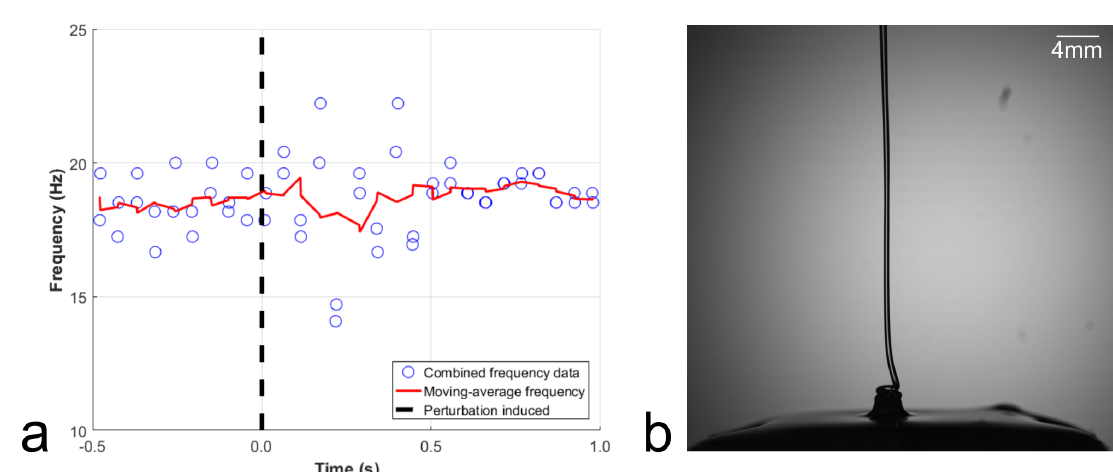
Figure 10. Steady coiling, using honey, around the inertial-gravitational regime induced with a perturbation.The flow rate was 0.85 mL · s − 1 from a fall height of 7 cm. ( a ) Coiling frequency oscillates in an unsteady manner for a brief period before returning to steady coiling once the perturbation has passed. ( b ) Image of the perturbation propagating along the coil can be observed in the slight bending of the falling